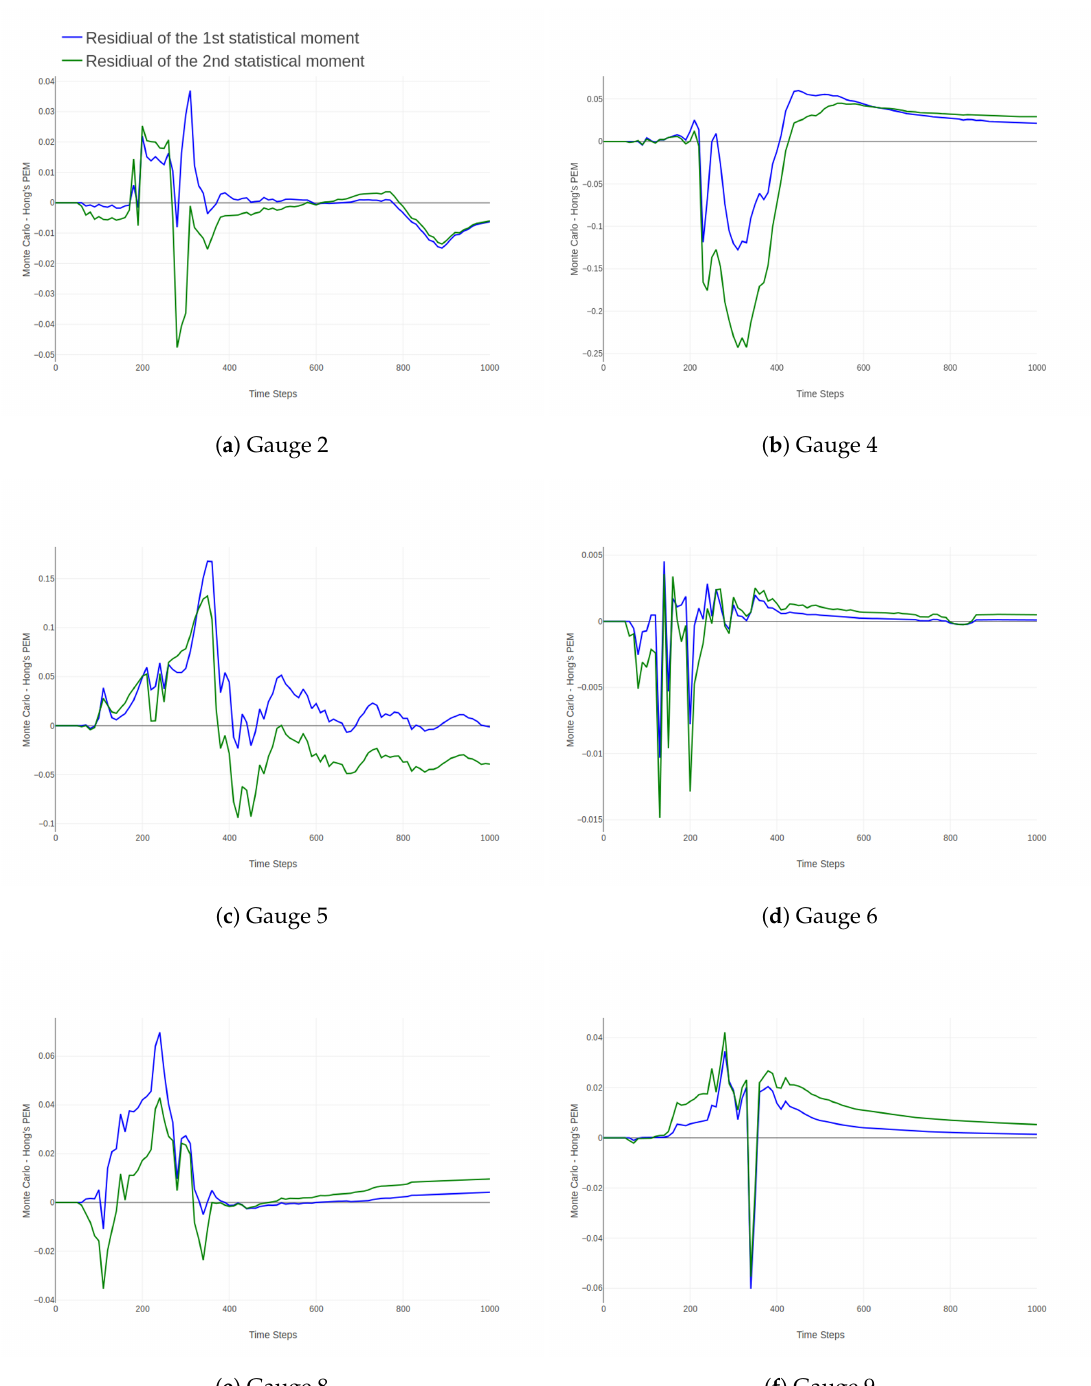
Figure 5. Residual plots showing similarities and differences between predictions made by MC simulation and